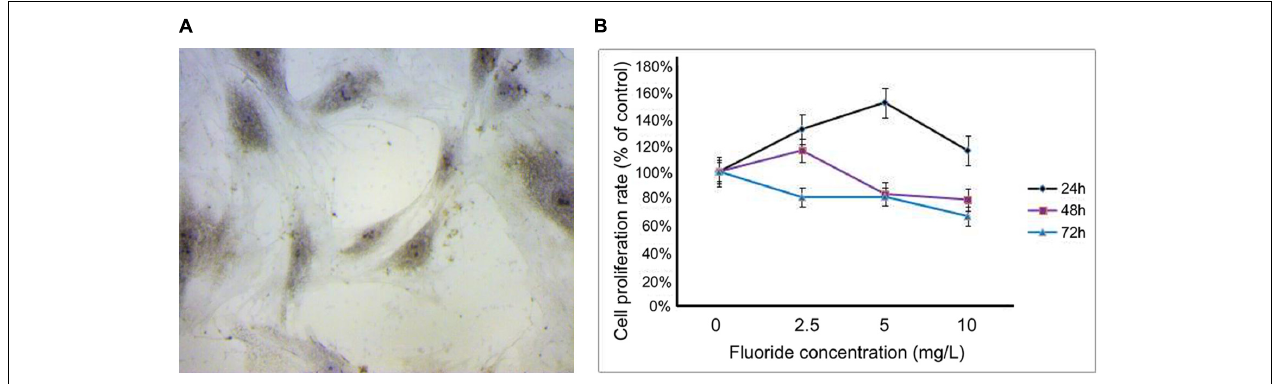
FIGURE 1 | Primary rat osteoblasts and cell proliferation rate after treatment with NaF. (A) Dark-brown granules in the cytoplasm of osteoblasts were observed after alkaline phosphatase staining. (B) Cell proliferation rate was measured using a cholecystokinin octapeptide assay at 24, 48, and 72 h after treatment, with fluoride at different concentrations (0, 2.5, 5, and 10